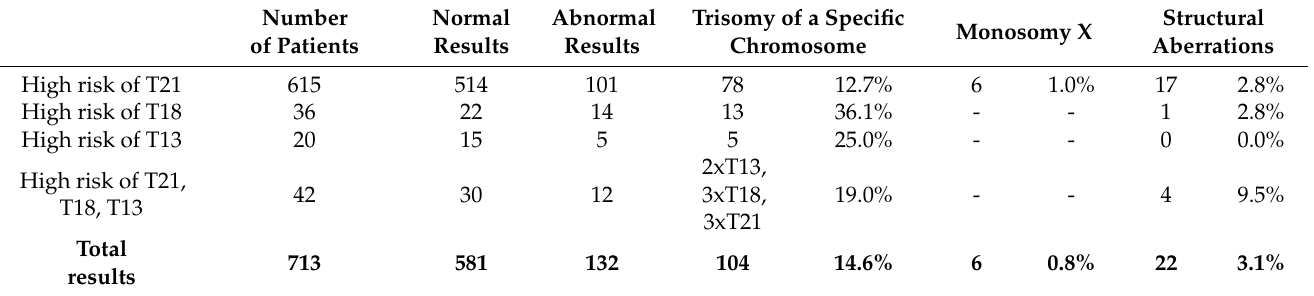
Table 4. The aCGH results of 713 samples with abnormal result in PAPP-A test and normal